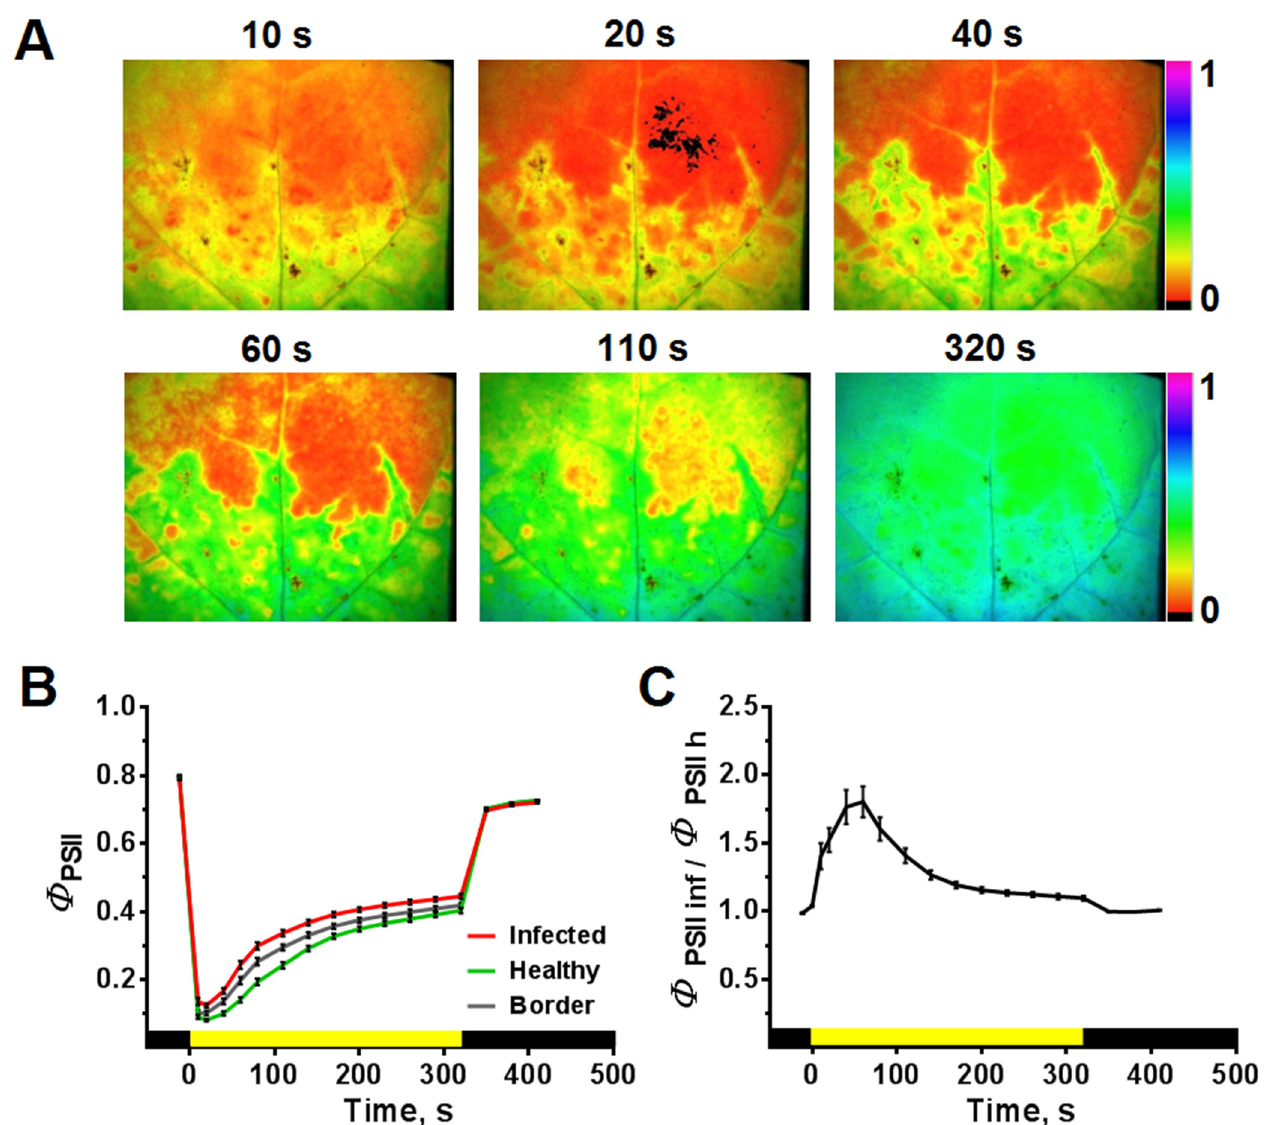
Figure 4. Influence of PVX on the time-course of the quantum yield of PSII ( Φ PSII ) ( n = 25): ( A ) Φ PSII images obtained from PVX-GFP infected tenth tobacco leaf at different times after actinic light (AL) was switched on. The color scale bars indicate the Φ PSII value given in false colors. ( B ) Φ PSII light-induced curves obtained from healthy, infected, and border areas of the leaf. ( C ) The ratios of the Φ PSII values of the infected and healthy areas of the leaf. The moment of the AL switching on is taken as zero. Values are mean ± SEM. The ratios of the Φ PSII values are statistically significantly differ from 1 in the range from 10 to 320 s ( t -test, p < 0.05). One-way ANOVA was performed to analyze the differences between ChlF parameters ratios (infected/healthy) at different time points of their dynamics (data are shown in Table S2).